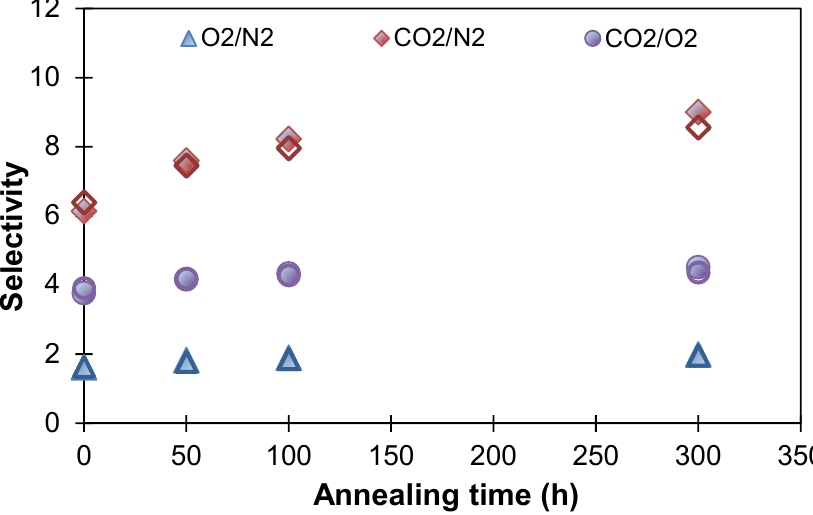
Figure 8. Changes in ideal selectivity for the initial PTMSP membrane (painted markers) and mem- brane from PTMSP purified by HCPS (unpainted markers) after annealing at 100 °C for 300 h.